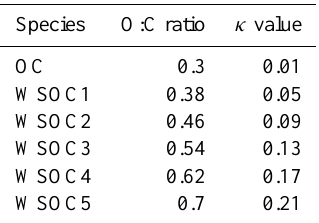
Table 1. List of O:C ratios and corresponding κ values for organic aerosol compounds.